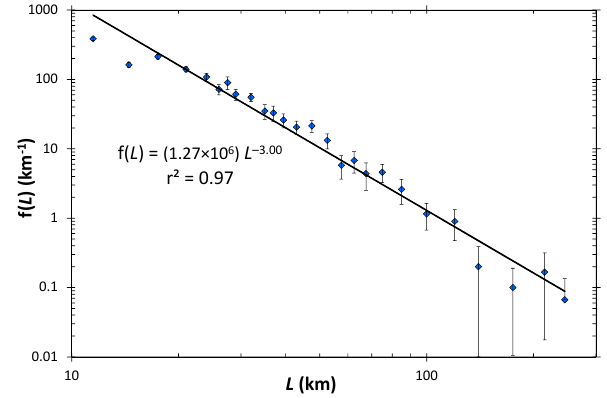
Fig. 10. For continental USA severe tornadoes ( L ≥ 10km; F j , j ≥ 0), 1982–2011, the frequency density f( L) is given as a function of path length L . Vertical error bars represent ±2 σ (±two standard deviations) of the frequency densities f( L ), and are calculated as ±(2 δN ) 0 . 5 / δL , where δN is the number of tornadoes in a “bin” from L to L + δL . The ±2 σ error bars are approximately equivalent to the lower and upper range of the 95% confidence interval (±1.96 σ ). The best-fit power-law correlation of the data is also given (Eq. 14). Tornado path length data L are from NOAA